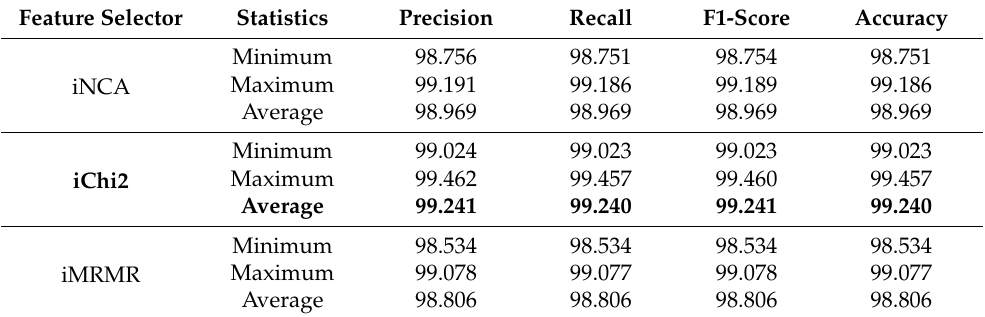
Table 7. Performance metrics for the support vector machine against each feature-selection technique.